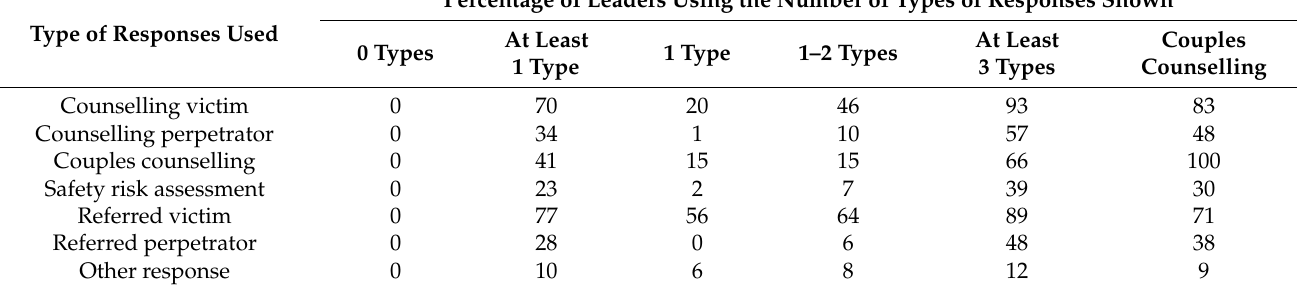
Table 2. Type and number of responses to DFV situations among senior local church leaders. Percentage of Leaders Using the Number of Types of Responses Type of Responses Used